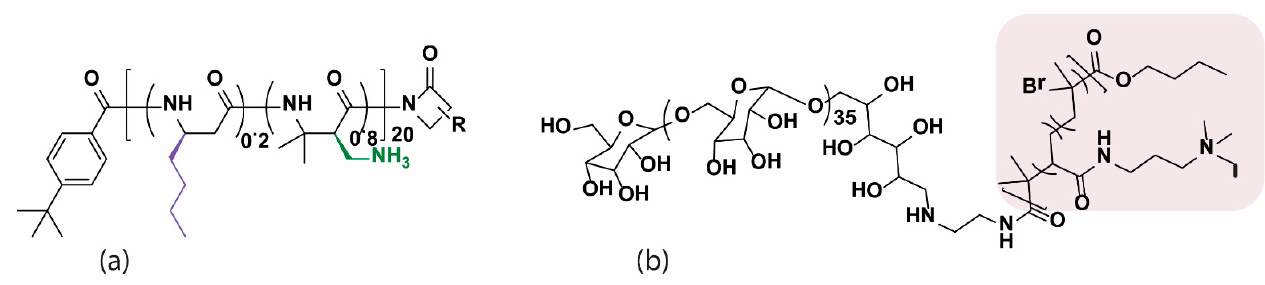
Figure 7. Examples of antibiofilm cationic HDP-mimicking polymers. ( a ) Cationic antimicrobial β -peptide polymer (20:80